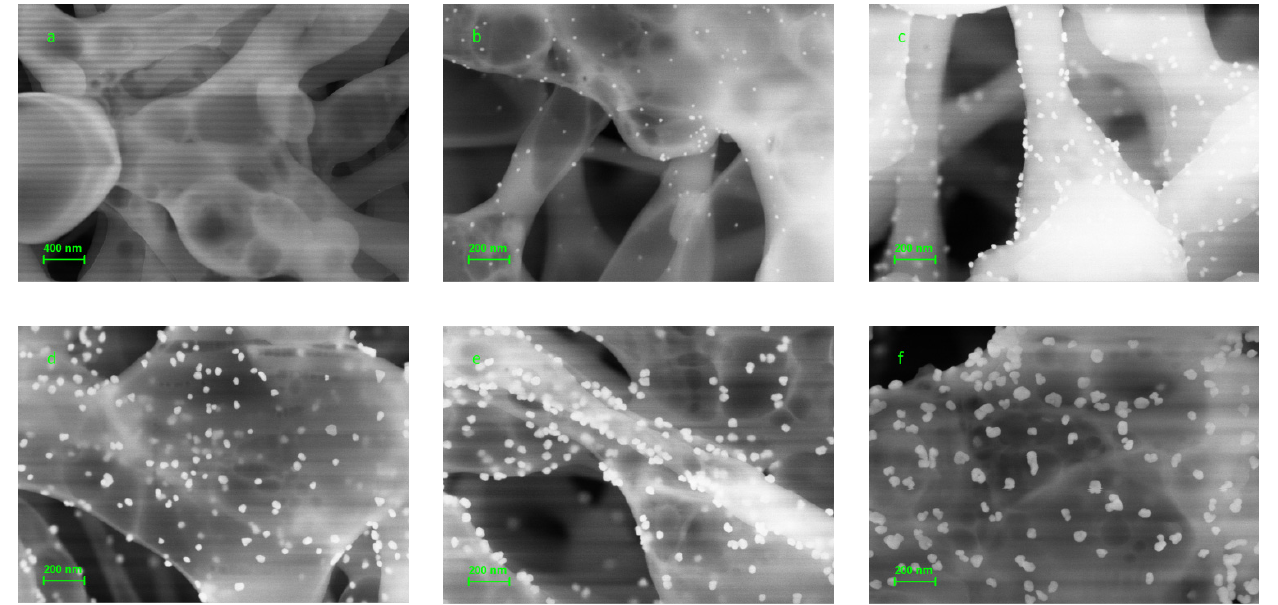
Figure 5. SEM images of the specific and control spots after hybridization of the membrane microarray with 150 pM of target oligonucleotide followed by enhancement procedure at pH range from 2.5 to 4.5. ( a ) Control spot; ( b ) specific spot without enhancement; ( c – f ) specific spot after enhancement at pH 2.5 ( c ); pH 3.0 ( d ); pH 3.5 ( e ); and pH 4.5 ( f ).